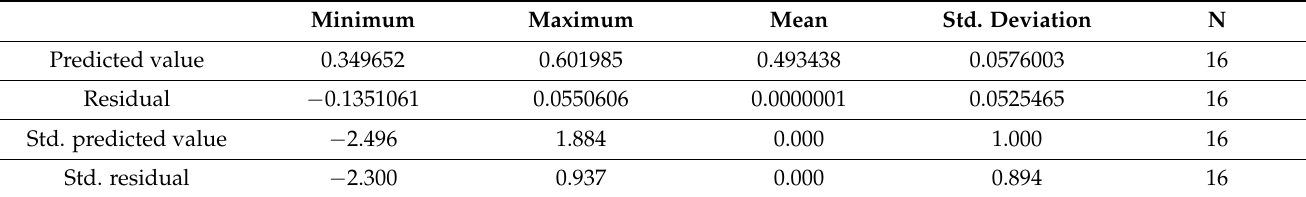
Table 10. Residuals statistics with three predictors.